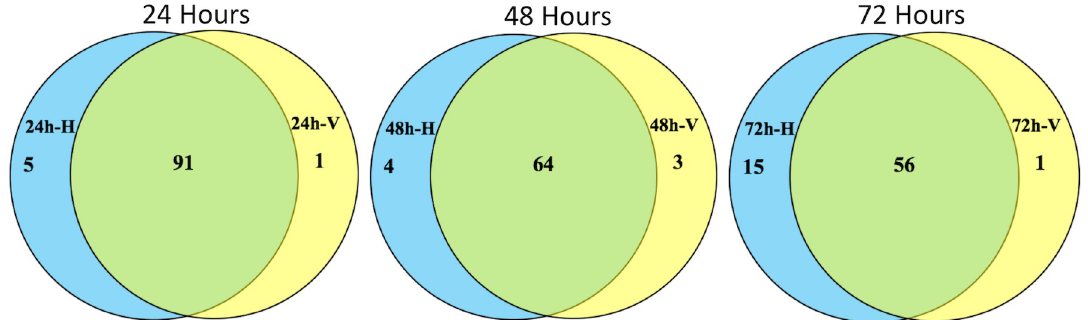
Fig 3. Comparison of identified piRNA clusters across three time points. Most piRNA clusters are common, and only handful of them are induced in whiteflies fed on TYLCV-infected tomato. 24 h-H, 48 h-H, and 72 h-H represents whiteflies fed on uninfected tomato for 24, 48 and 72 hours, respectively. 24 h-V, 48 h-V, and 72 h-V represents whiteflies fed on TYLCV-infected tomato for 24, 48 and 72 hours,